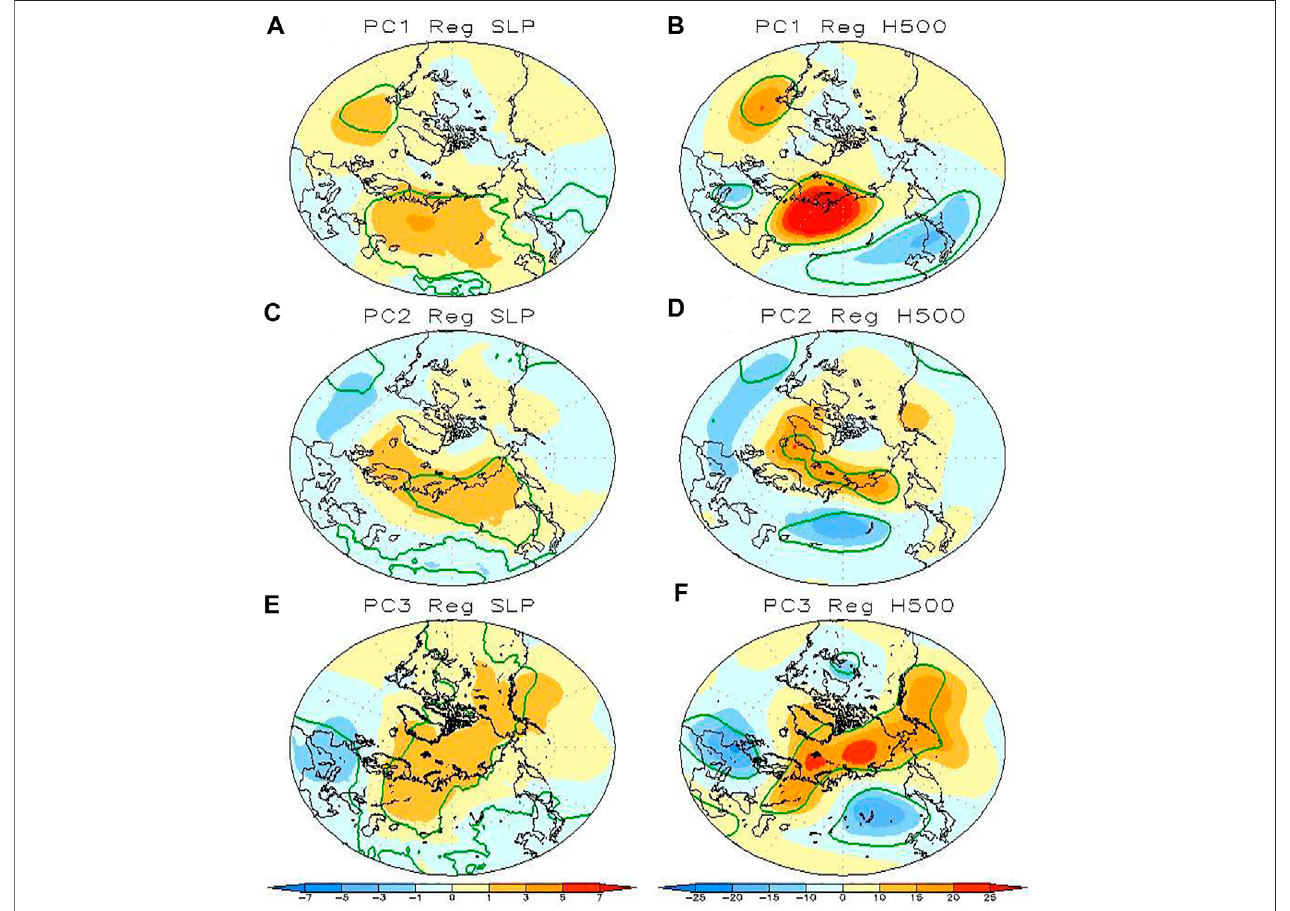
FIGURE3| RegressedanomaliesofDJF (A) SLP(shading,units:hPa), (B) 500 hPageopotentialheight(shading,units:m)ontothePC1index, (C,D) ontothePC2 index, and (E,F) onto the PC3 index. The green line indicates the value signi fi cantly exceeding the 95% con fi dence level.